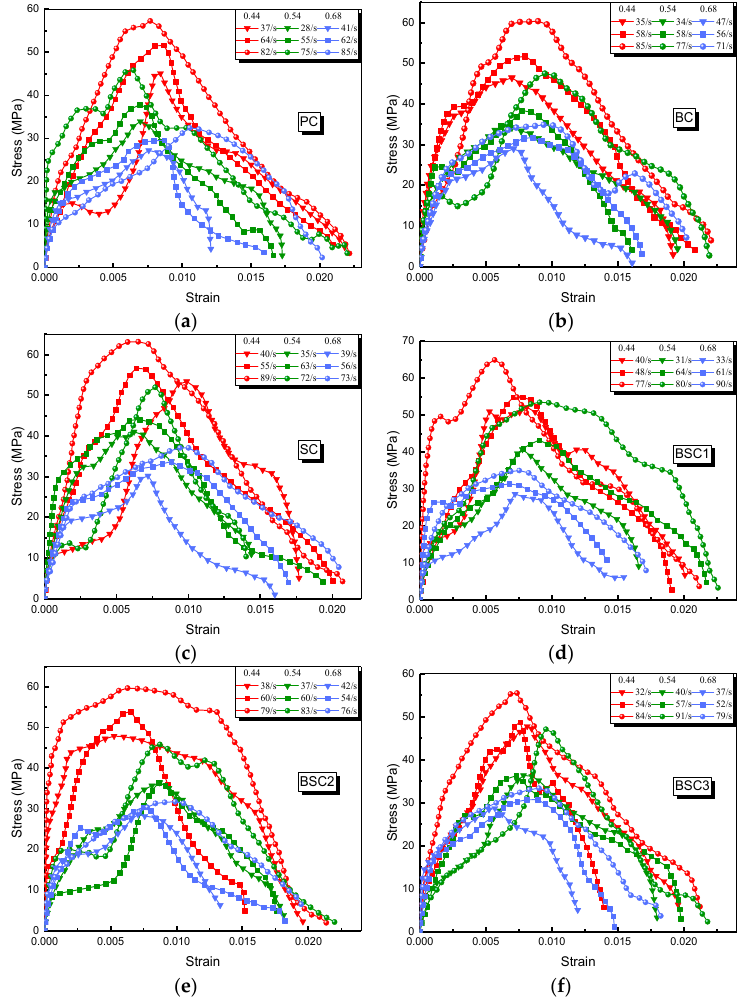
Figure 11. Impact stress–strain curves in the SHPB test: ( a ) PC; ( b ) BC; ( c ) SC; ( d ) BSC1; ( e ) BSC2; ( f ) BSC3.